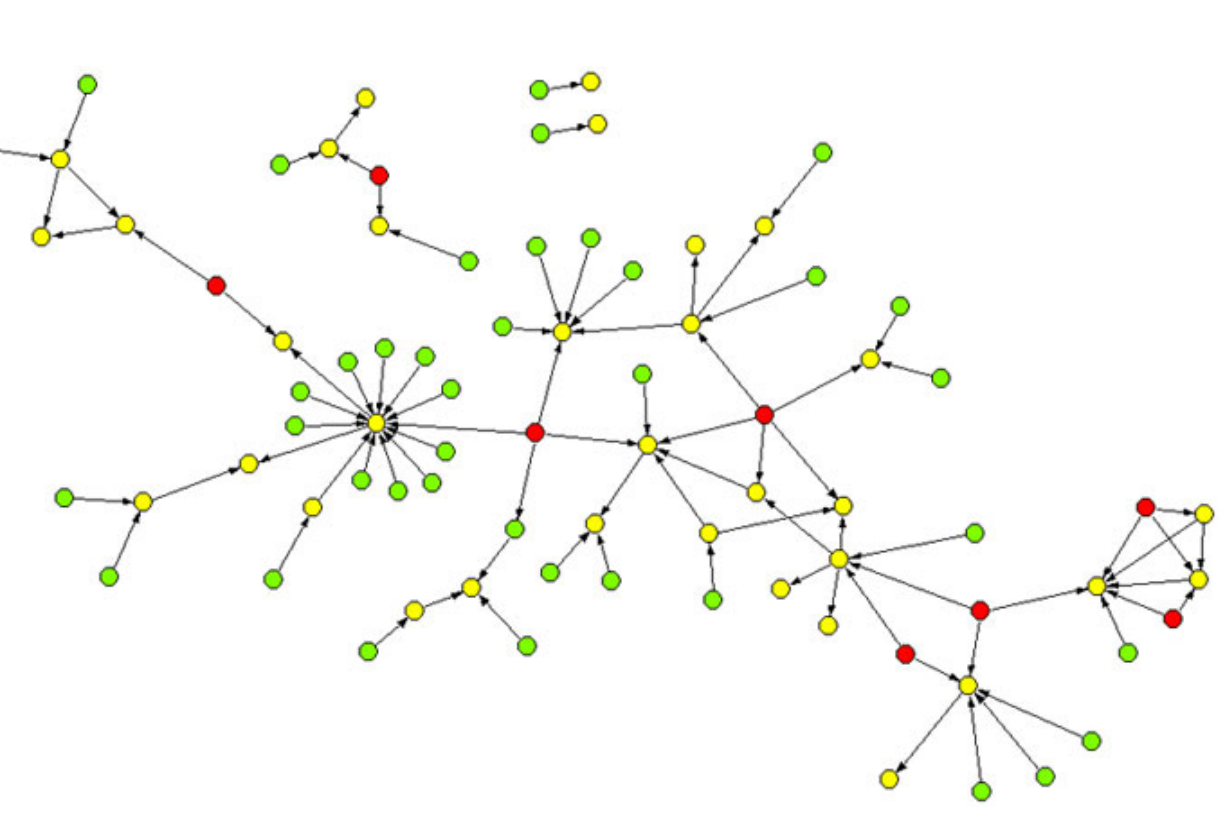
Fig. 3. Network of gear exchange among